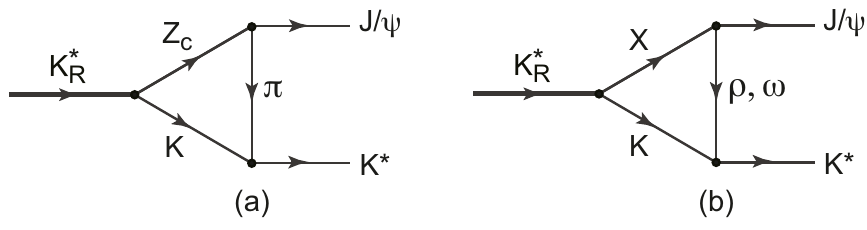
Figure 1 . Decay mechanisms of the K (cid:3) state predicted in ref. [29] to the J= K (cid:3) channel. The R vertex X ! J= (cid:26) ( ! ) on the diagram (b) involves yet another triangular loop, as shown in (cid:12)gure 3.